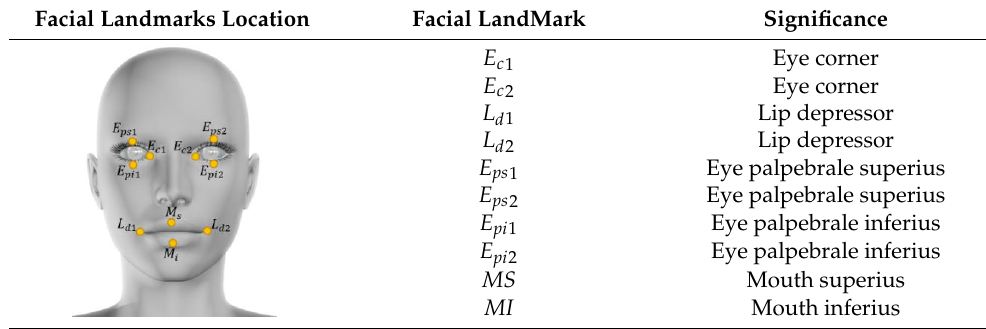
Table 1. Facial landmarks significance.